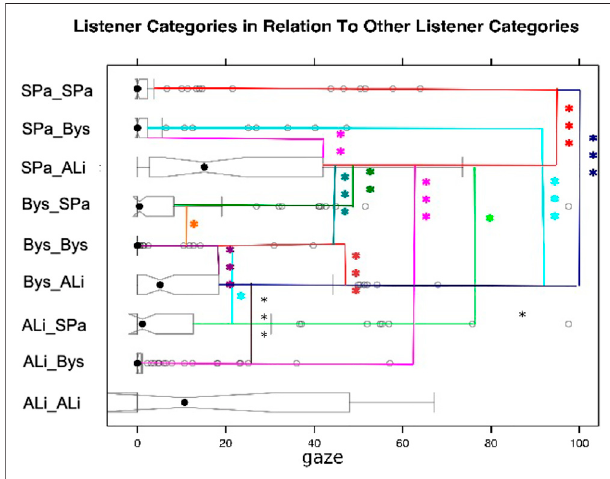
FIGURE 3 | Gaze patterns between listener